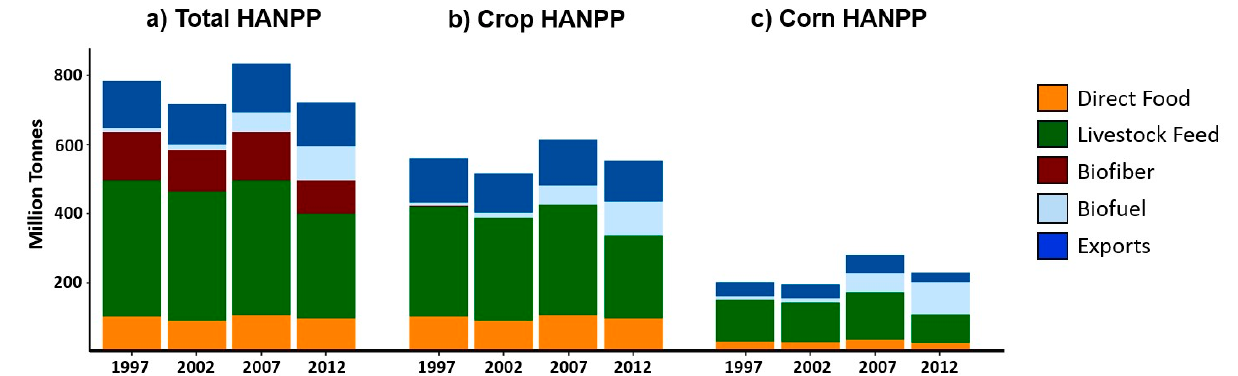
Figure 3. U.S. HANPP allocations in tons in 1997, 2002, 2007 and 2012 allocated to human food, livestock feed, biofiber, biofuel and exports for ( a ) Total HANPP, ( b ) Crop HANPP, and ( c ) Corn HANPP. Table 2. Proportions of specific major crops, timber products and livestock grazing allocated to food, livestock feed, biofiber, biofuel and exports in 1997, 2002, 2007 and 2012.